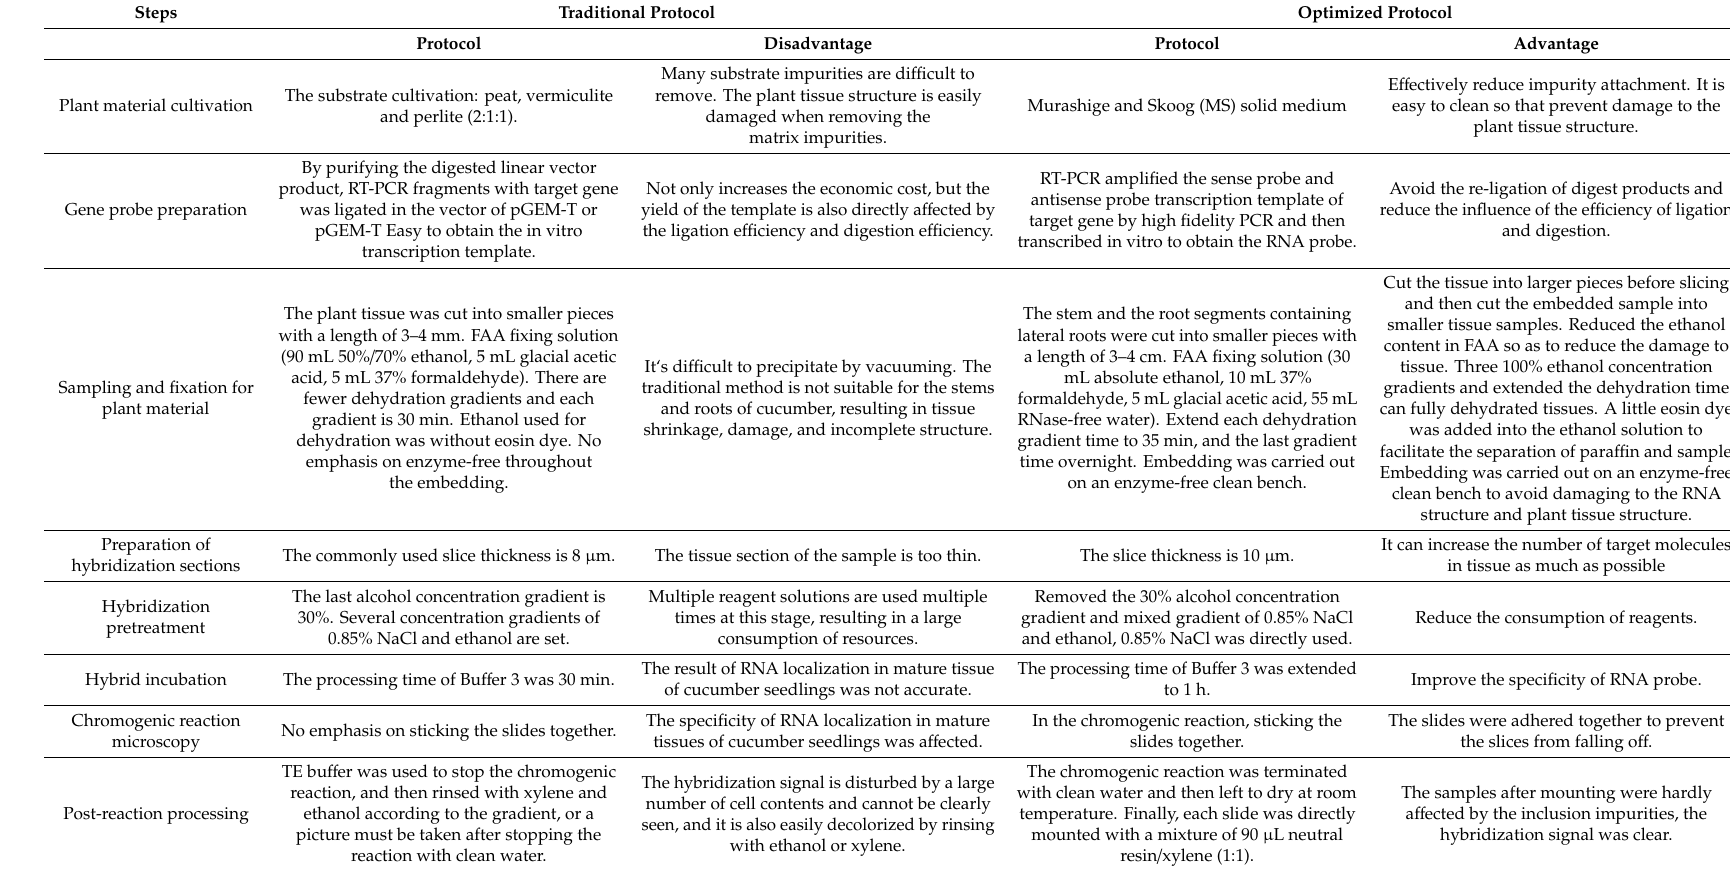
Table 2. Comparison of traditional and improved in situ hybridization